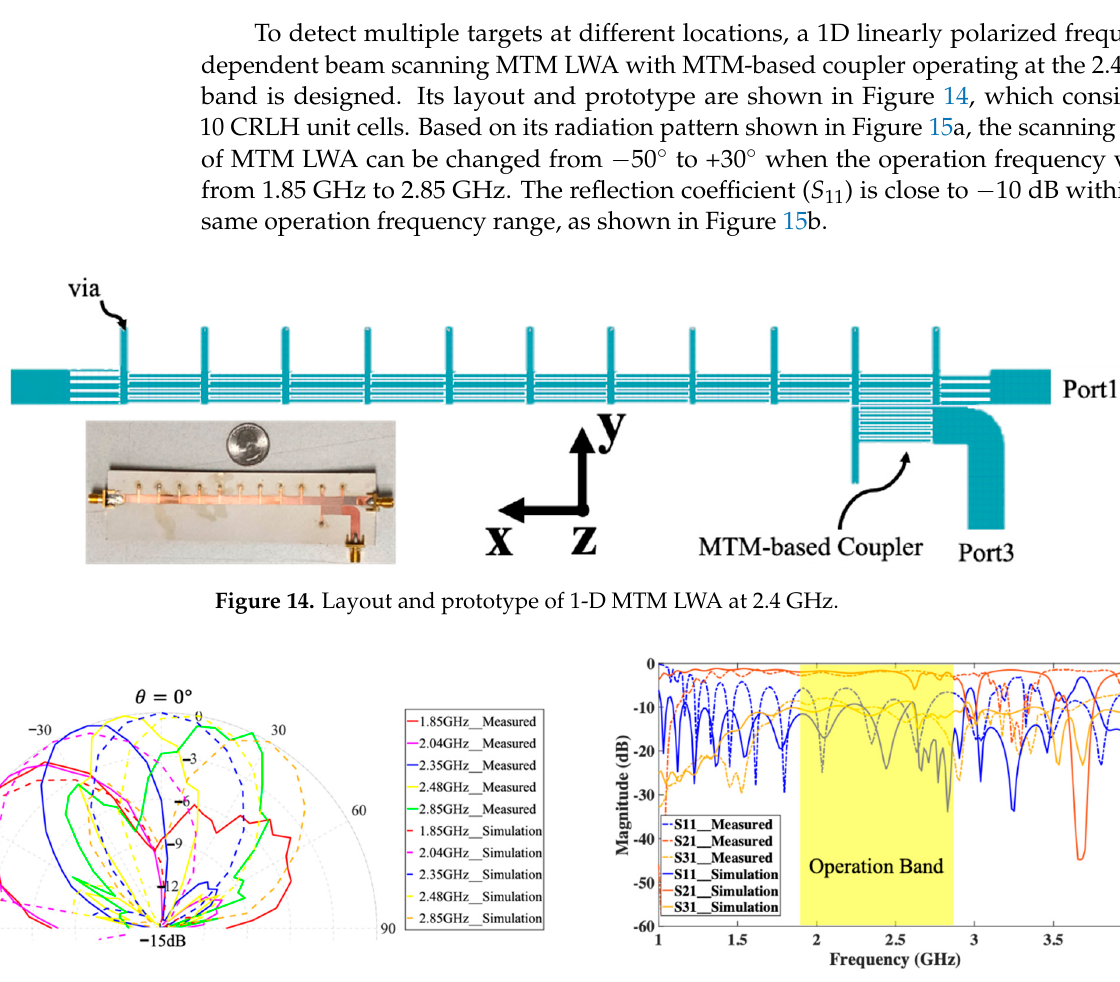
Figure 13. The block diagram of proposed MTM LWA based on self-injection-locked (SIL) radar sensor architecture, illuminating two distinct operation frequencies to two targets.